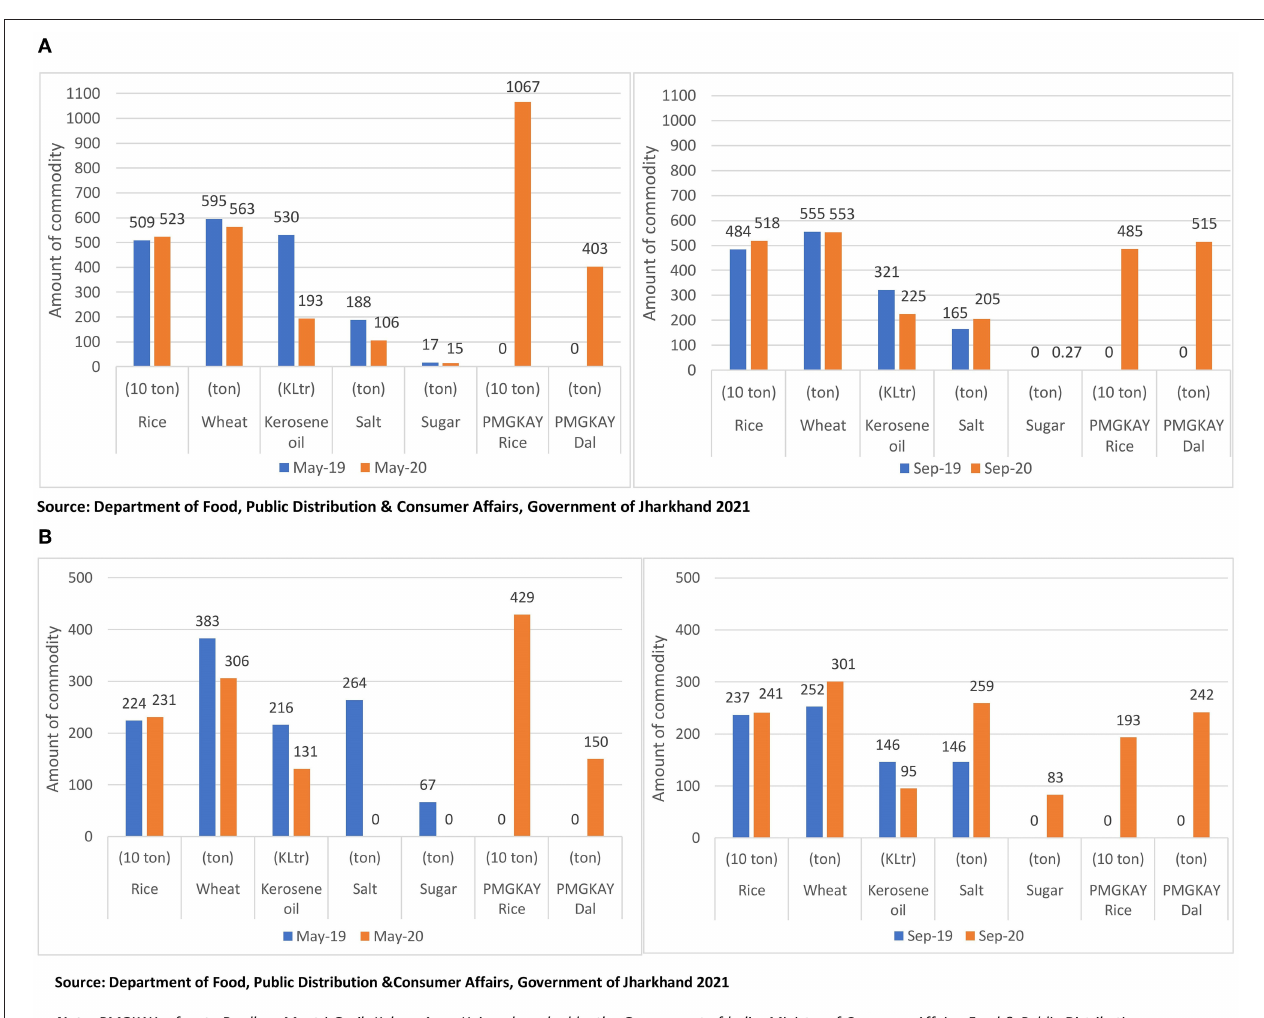
FIGURE 9 | Distribution status of communities under PDS in study districts of Jharkhand. (A) Transaction status of various commodities under PDS during pre-covid time (May 2019) v/s lockdown time (May 2020) and pre-covid time (September 2019) v/s unlock time (September 2020) in Godda, Jharkhand. (B) Transaction status of various commodities under PDS during pre-covid time (May 2019) v/s lockdown time (May 2020) and pre-covid time (September 2019) v/s unlock time (September 2020) in Khunti, Jharkhand. Source: Department of Food, Public Distribution and Consumer Affairs, Government of Jharkhand,